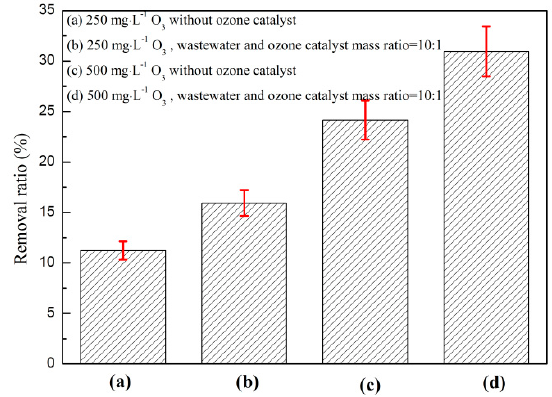
Figure 1. Effect of catalyst and O 3 on coking wastewater treatment via ozone catalytic oxidation.